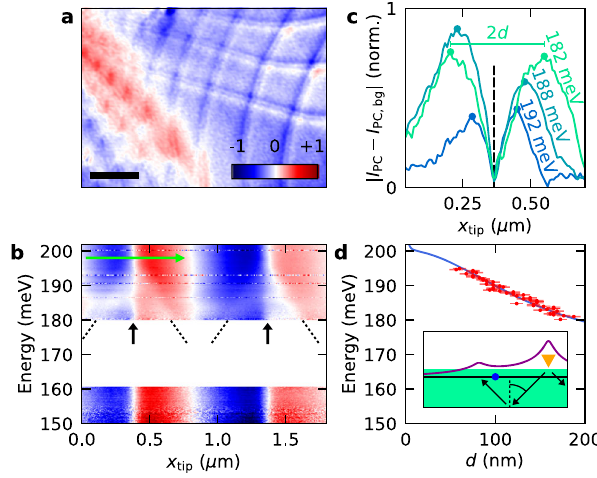
Fig. 4 Anomalous photocurrent and non-local heating via polariton rays. a Spatial map of the normalised photocurrent ( I PC ) at an excitation energy of 117 meV and doping n ~ 4 × 10 12 cm − 2 . Length of scale bar: 500 nm. b Normalised I PC as a function of excitation energy and excitation position ( x tip ) crossing two domain walls (marked by black arrows) in another of our mTBG samples. Colour code: blue: − 1, red: + 1. The dashed lines are guides to the eye showing the dispersive nature of the double-step feature, which appears as a local reduction of the photocurrent magnitude on either side of the domain wall. The white area corresponds to a gap in the spectrum of our laser. c Line traces (as absolute value) of a few energies taken from b (see green arrow in b ) plotted after background subtraction; the background is experimentally extracted from the line trace at 202 meV where the double-step feature is not observed. We de fi ne the distance between the peaks as 2 d . d Distance between the domain wall and observed peak ( d ) plotted for different excitation energies (red dots), along with a fi t to a λ ray (blue line). We estimate the error in d to be ±7.5 nm based on the spatial resolution of our scan. The inset is a schematic showing the thermal pro fi le (purple) induced by light coupled in via the AFM tip (yellow triangle). In addition to heating the electron lattice, the tip also excites hBN phonon rays (black arrows), which are able to propagate to the opposite side of the domain wall (blue dot) and cause additional heating that produces a photocurrent contribution of the opposite